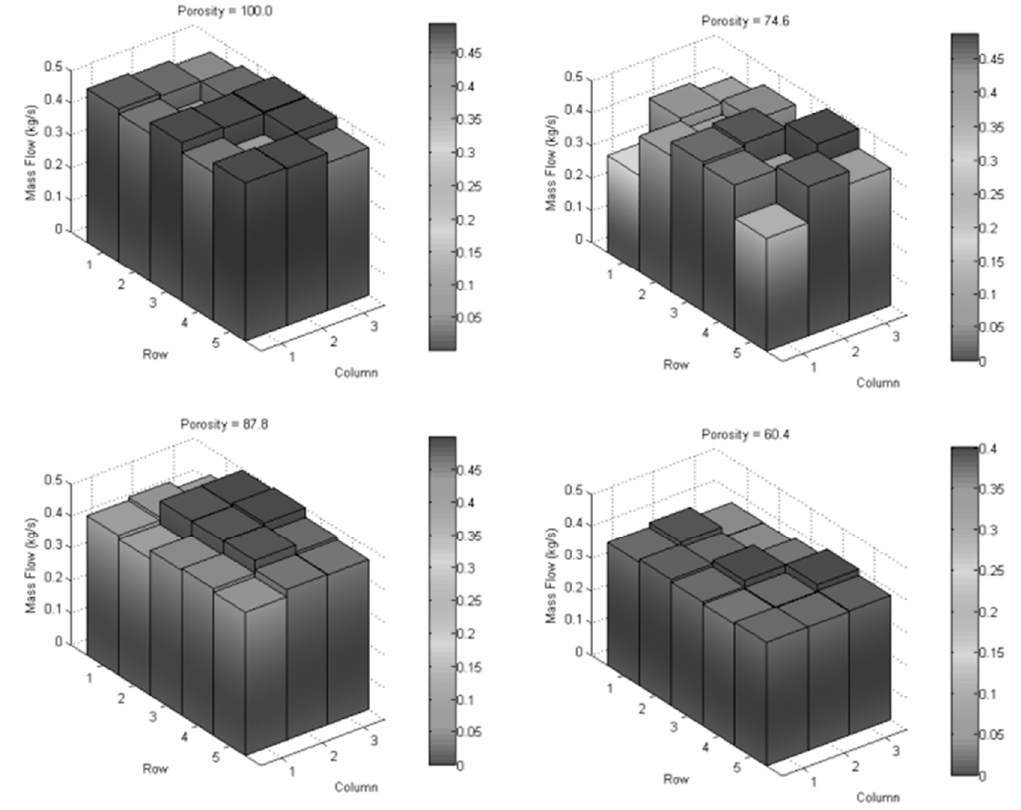
Figure A2. MIT Wind Tunnel Results: Mass flow in each accelerator of the array for 100%, 87.8%, 74.6%, and 60.4% porous arrays